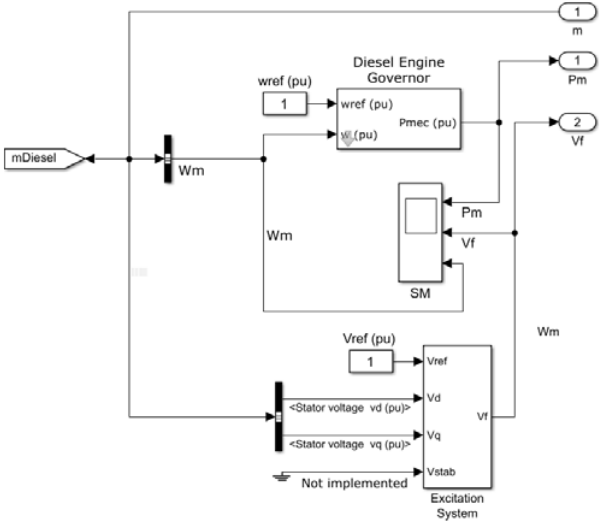
Figure 2. Model of AVR and ASR of diesel generator